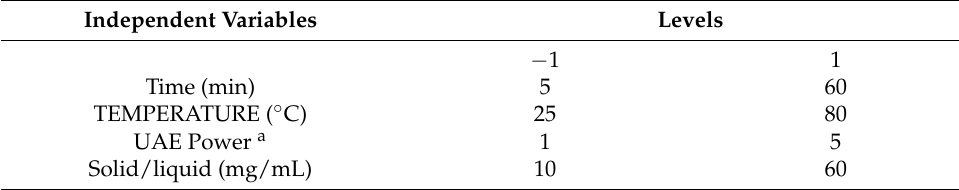
Table 1. Factors and levels selected for the design of